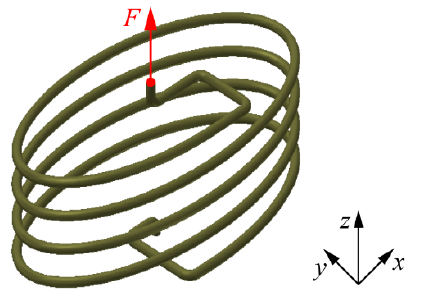
Figure 13. Configuration of the refueling pipe. The red point represents the connecting point of the drogue and the refueling pipe, which is subjected to the force F along the z -axis.